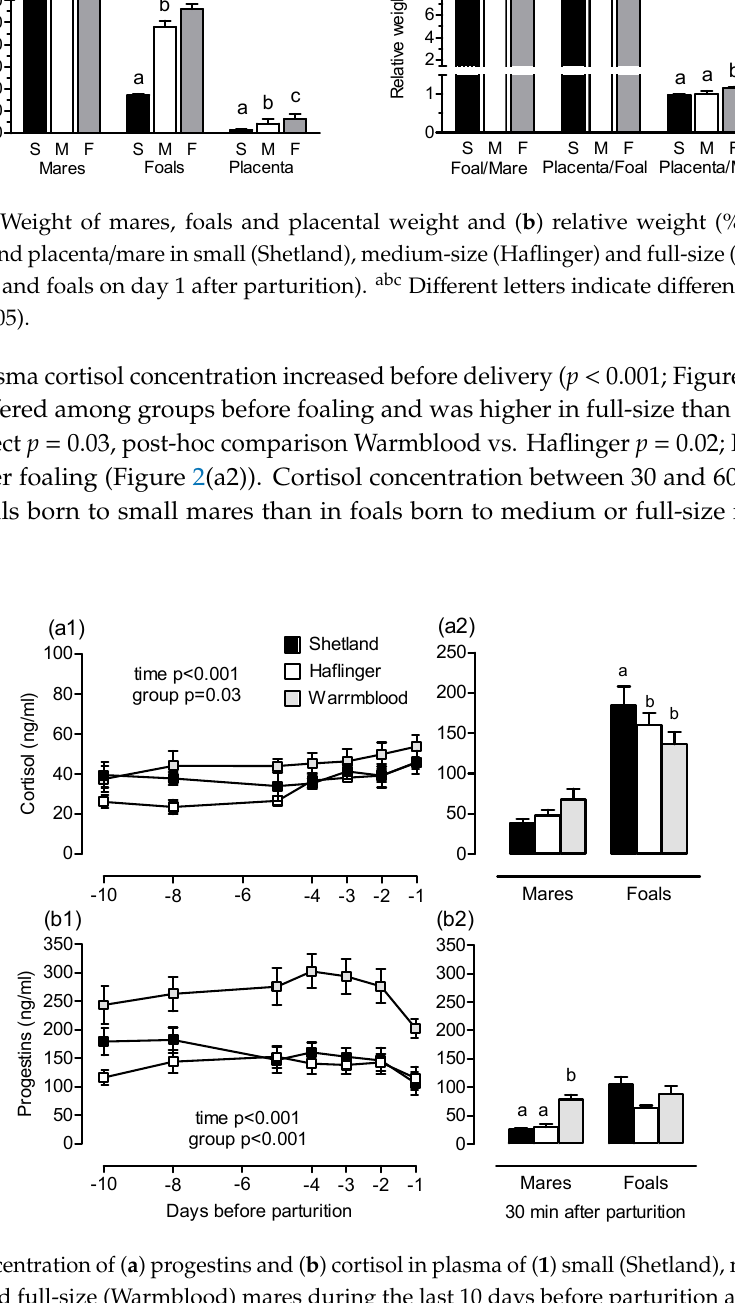
Figure 1. ( a ) Weight of mares, foals and placental weight and ( b ) relative weight (%) foal/mare, placenta/foal and placenta/mare in small (Shetland), medium-size (Haflinger) and full-size (Warmblood) horses (mares and foals on day 1 after parturition). abc Different letters indicate differences between groups ( p < 0.05).